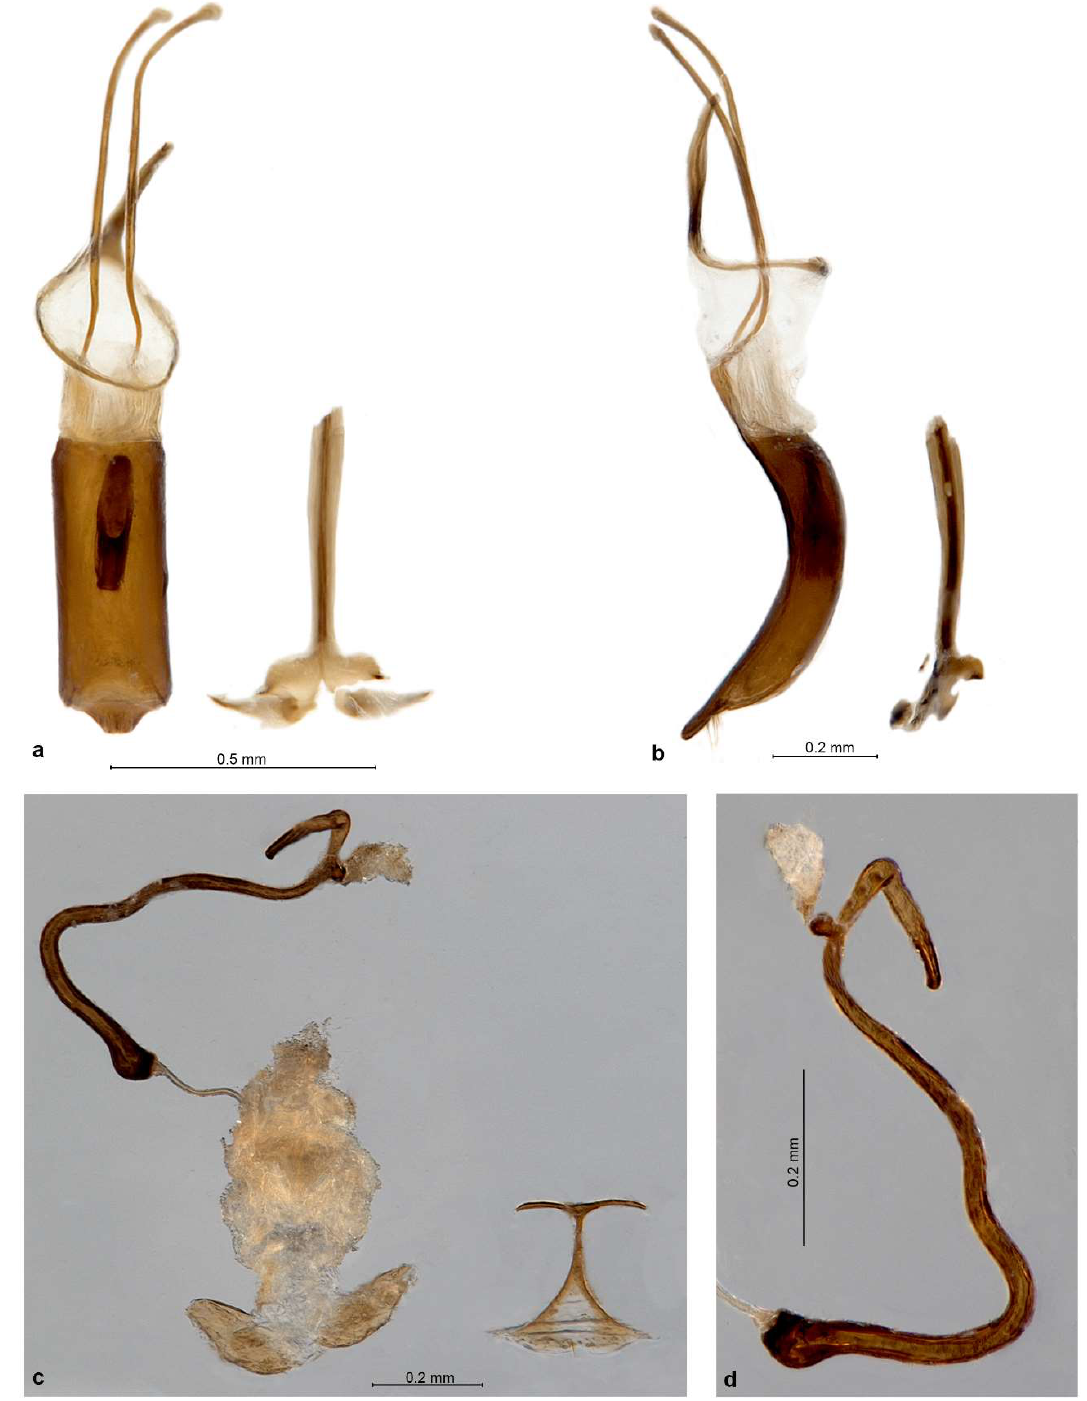
Figure 5. Philetaerobius louwi sp. n., genitalia. ♂ (SWA [Namibia]), aedeagus and sternite IX, dorsal view ( a ); ditto, left lateral view ( b ); ♀ (Us Pass), ovipositor and sternite VIII, dorsal view ( c ); ♀ (Us Pass), spermatheca, dorsal view ( d ).